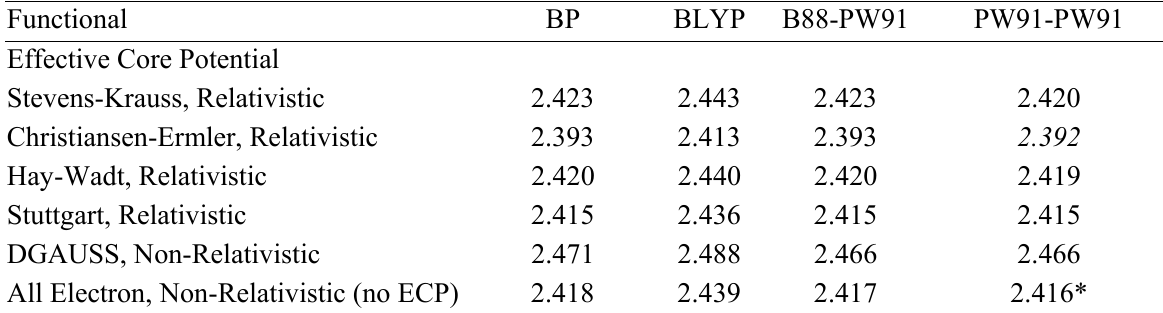
Table 3 . Rh-Rh bond lengths (Å) using